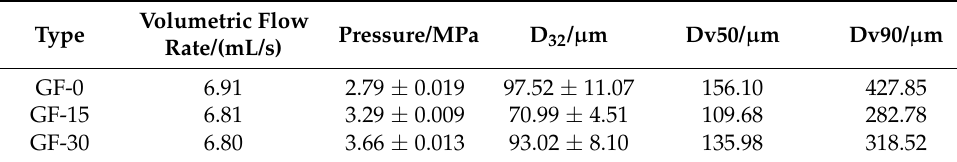
Table 4. The injection pressure and the mean droplet diameters of the self-excited oscillation nozzle for different gelled fuels.